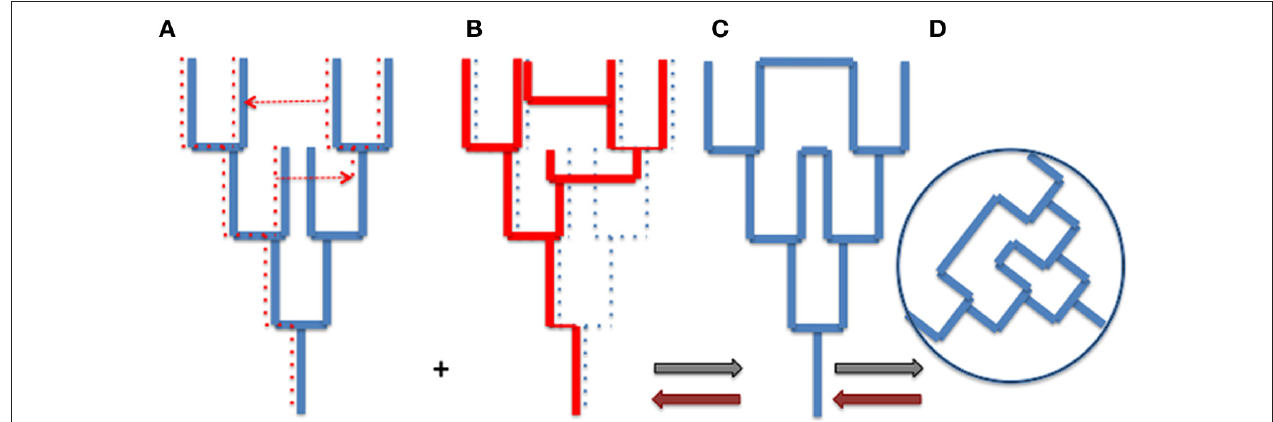
FIGURE 1 | Fromtreestowebsandback.(A) anorganismtreecorresponding to its vertically inherited genes(blue), (B) an underlyinggene tree [dottedlines in (A) ] with one loss and two horizontalgene transfers [indicated by dotted